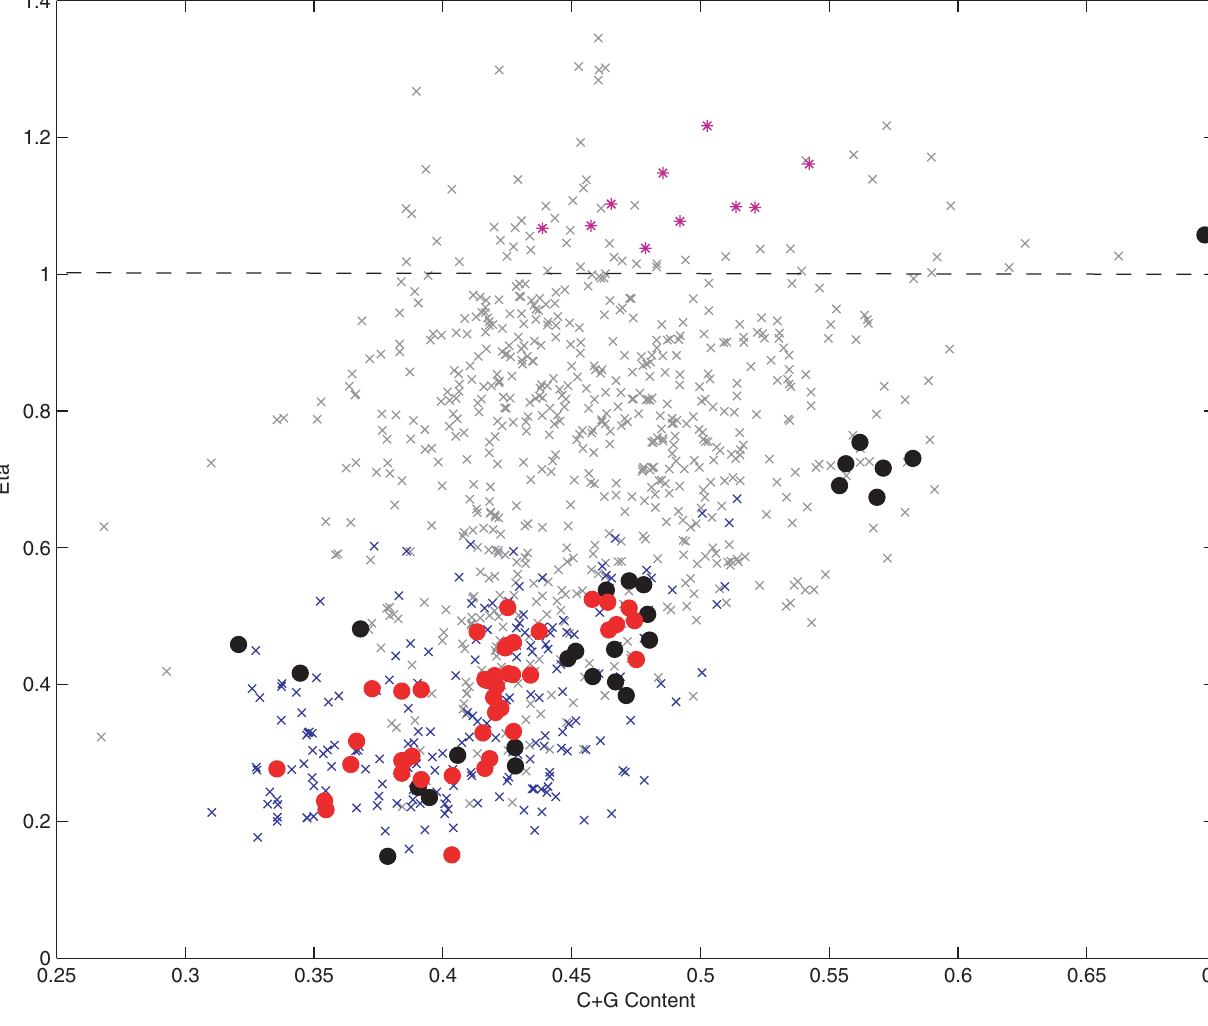
Figure 1. CpG odds ratio ( g ) versus C + G content for different ssRNA viruses. A value of g close to 1 (marked in the figure with a dashed line), means that the measured value is very close to the expected, i.e. no significant pressure to create or eliminate CpGs. Most ssRNA viruses have strong pressure to eliminate CpGs. Human viruses, marked with black (ssRNA + ) and red (ssRNA 2 ) filled circles, are at the lower part of the CpG distribution for a given nucleotide content. In particular, the lowest ssRNA viruses in this set are Hepatitis A and Hemagglutinin in influenza C, both human viruses. In contrast, phages do not show any such pressure the remaining viruses, which mostly occur in plants and insects, do not show any significant pressure. All phages listed are ssRNA +